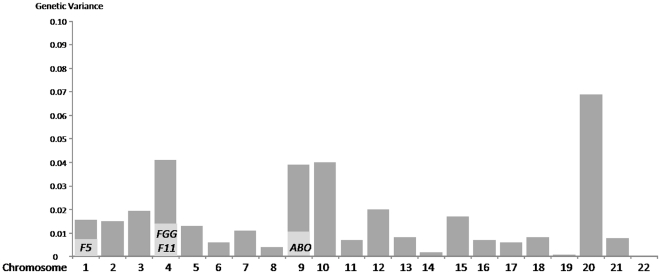
Distribution of VT genetic variance across chromosomes.In light grey is shown the relative contribution of specific loci.